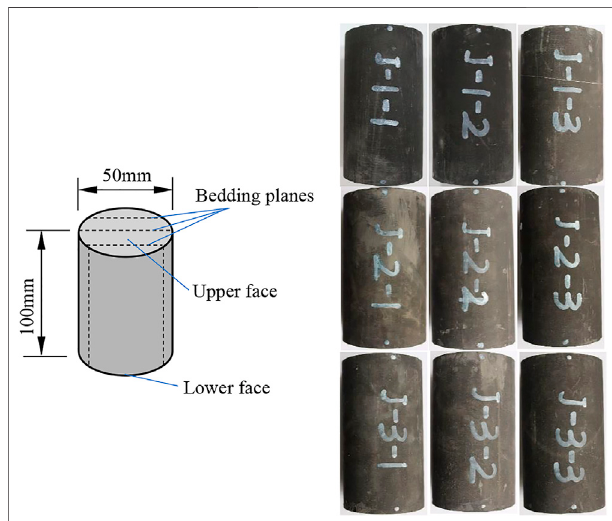
FIGURE 2 | Prepared standard